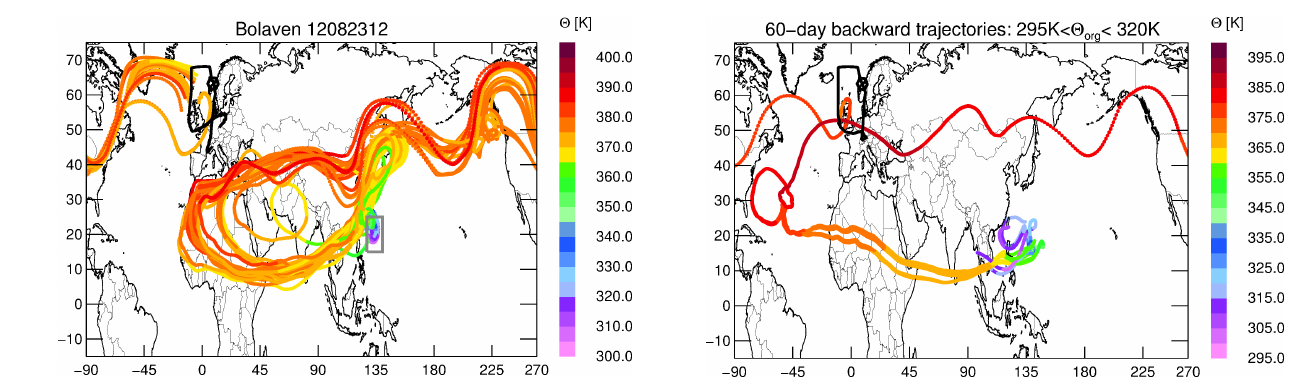
Fig. 9. Different 60-day backward trajectories for the tropospheric signal between 08:05UTC and 08:23UTC (see Fig. 2; enhanced values of CH 4 , CO , and H 2 O and reduced O 3 occurring before the region of interest) originating at a low level of potential temperature ( Θ org = 295–320K). The very rapid uplift over Southeast Asia is caused by typhoon Haikui.